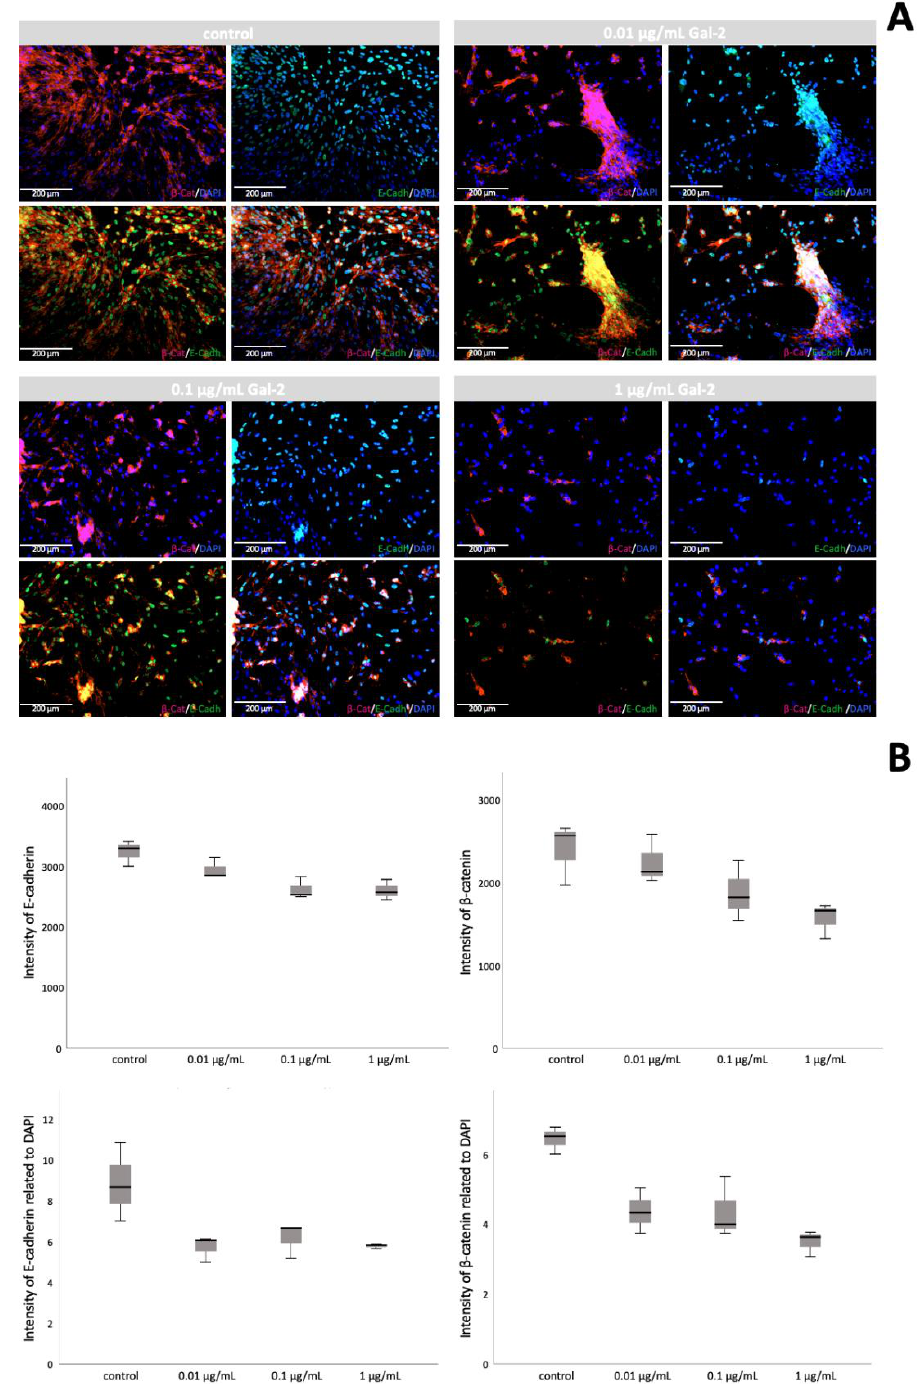
Figure 3. Induction of cell fusion by increasing the concentration of Gal-2 in HVT cells. ( A ) Exem- plary images of cell fusion staining of HVT cells using β -catenin (red) and E-cadherin (green) after incubation with different concentrations of Gal-2. Nuclear staining with DAPI is shown in blue. Co-expression of β -catenin and E-cadherin results in yellowish staining. ( B ) Boxplots of the staining results of E- cadherin and β -catenin after incubation with increasing Gal-2 concentrations: mean in- tensity (upper row); mean intensity related to DAPI (bottom row).